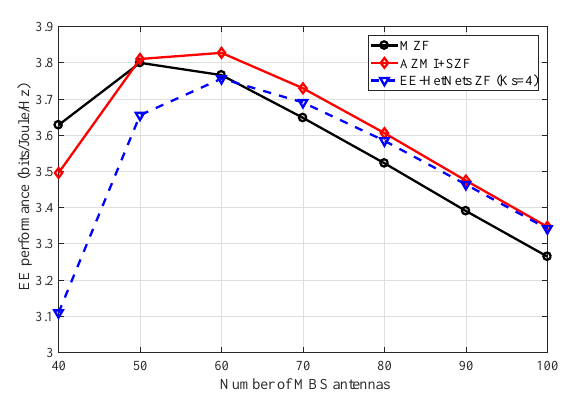
Figure 2. The EE performance versus the number of MBS antennas in a scenario of massive MIMO HetNets. Circle cell structure with radius 1000 m is setup with a centrally located MBS equipped with large-scale antennas, 6 SBSs equipped with 4 antennas and > 30 single-antenna users randomly distributed. Other simulation parameters are as follows: carrier frequency = 2 GHz, Bandwidth = 10 MHz, MBS and SBSs transmission power = 46 dBm and 30 dBm, path-loss model of MBS and SBS 128 . 1 + 37 . 6 log R dB and 140 . 7 + 36 . 7 log R dB 10 10 (R in km), noise power density − 174 dBm/Hz. The throughput threshold per user is 4